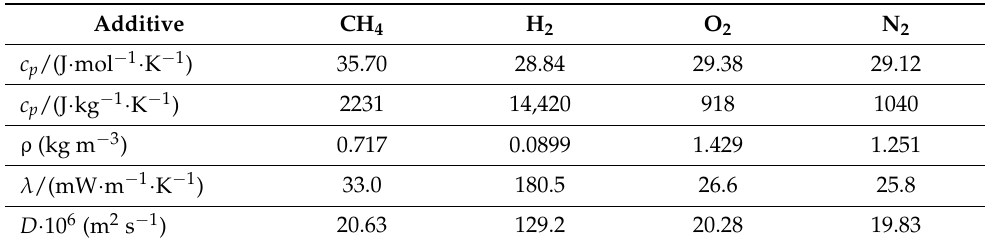
Table 4. Heat capacities, c p , densities, ρ , thermal conductivities, λ , and thermal diffusivities, D , of gaseous components [75].